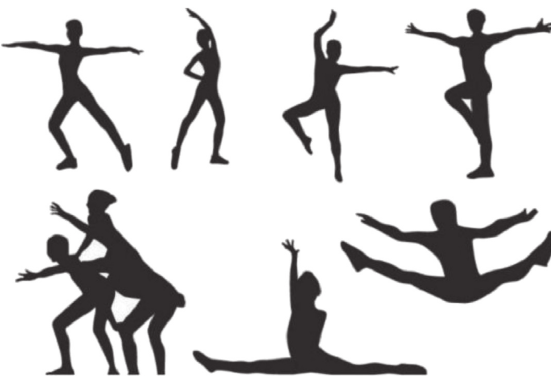
Figure 7: Denoising output image of aerobics action image.